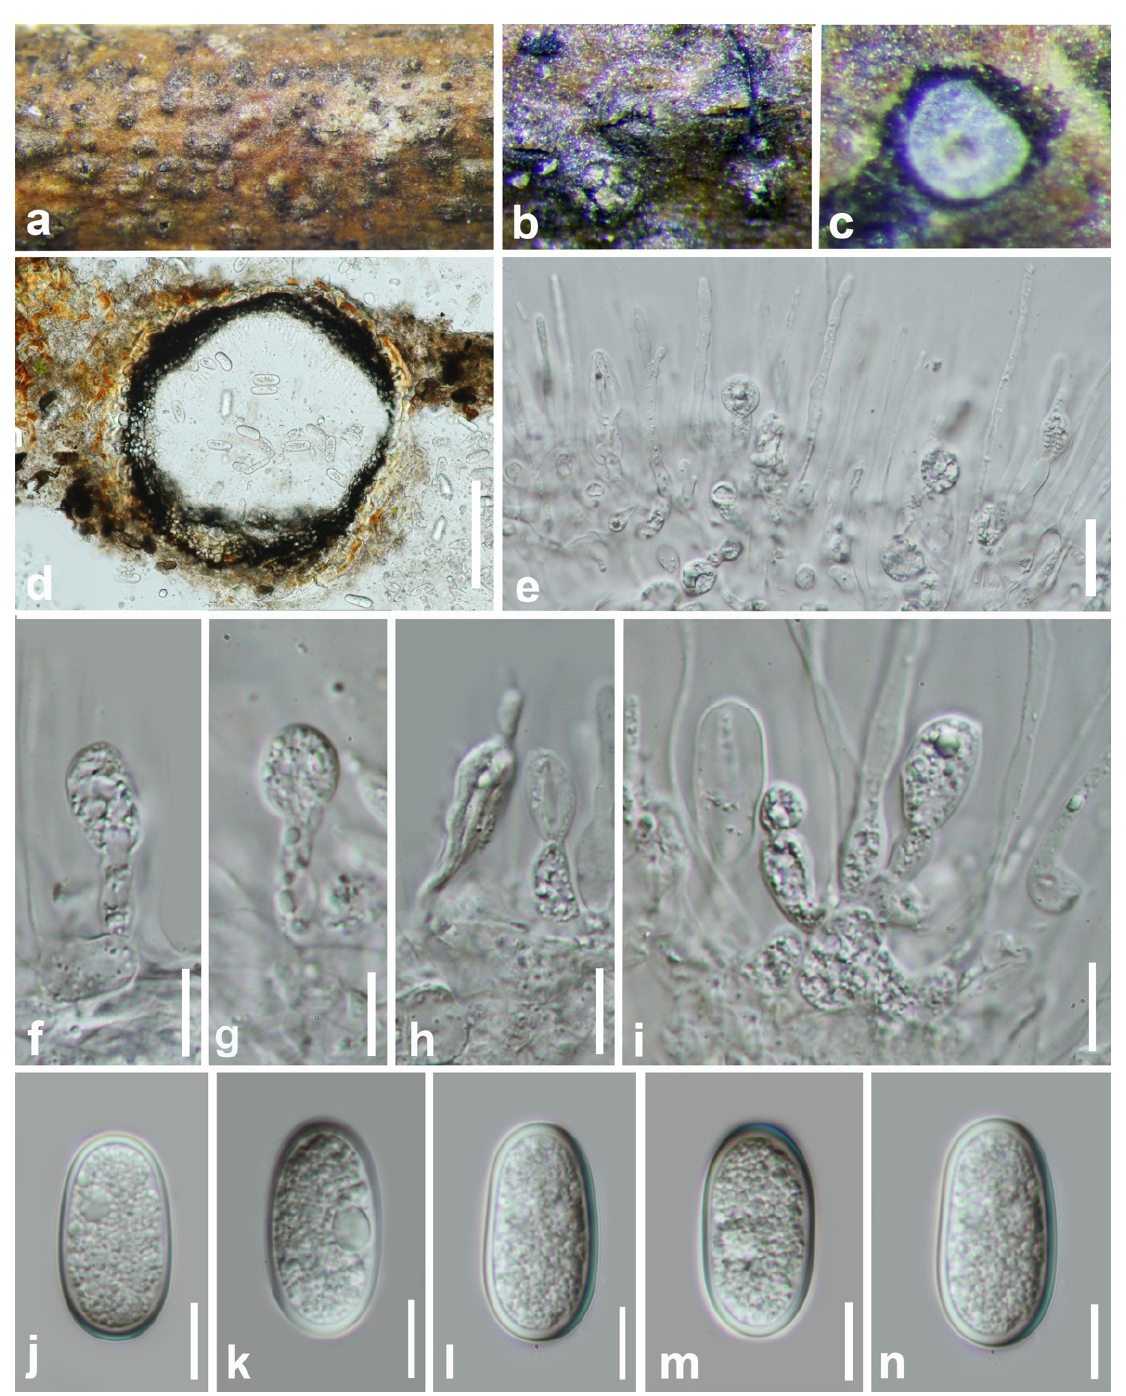
Figure 8. Sardiniella guizhouensis (GZAAS 19-1809, asexual morph). ( a , b ) Conidiomata on host surface. ( c ) Horizontal section of conidiomata. ( d ) Vertical section of conidiomata. ( e – i ) Conidiogenous cells and developing conidia. ( j – n ) Hyaline conidia. Scale bars: ( d ) = 100 µm, ( e – n ) = 10 µm.